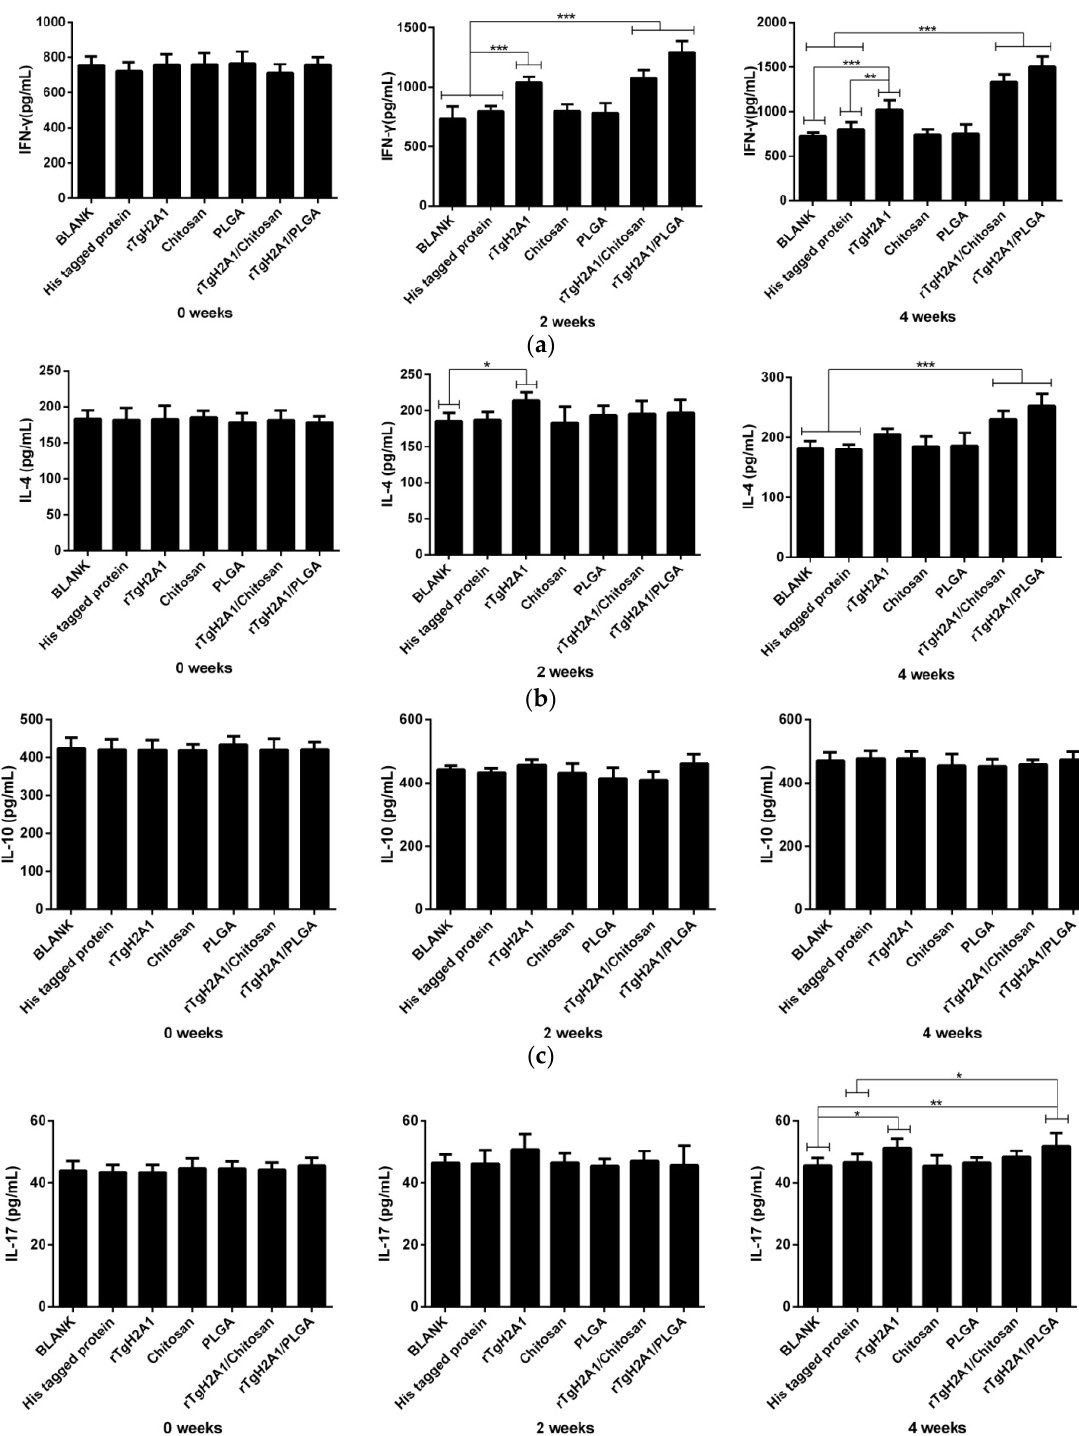
Figure 8. Cytokine production. Double antibody sandwich ELISA kits were used to determine the level of IFN-γ ( a ), IL-4 ( b ), IL-10 ( c ), and IL-17 ( d ) in sera from animals collected at weeks 0, 2, and 4. Results were evaluated using one-way ANOVA analysis followed by Dunnett’s test, and values were shown as mean ± standard deviation of pg/mL. * p < 0.05, ** p < 0.01, and *** p < 0.001 compared with the blank group or his-tagged protein group.